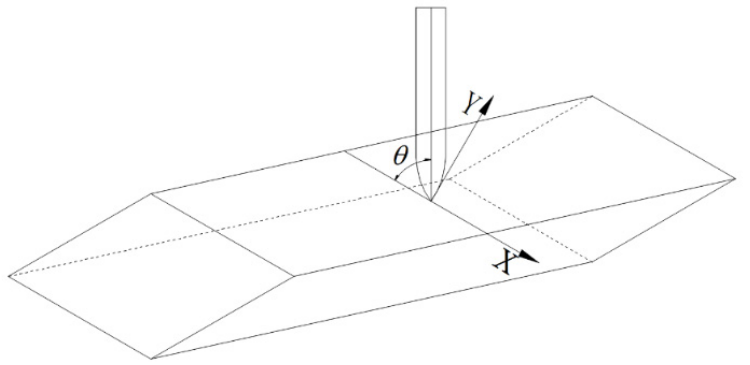
Figure 2. The coordinate system of the projectile penetrating the diamond-shaped moving target.